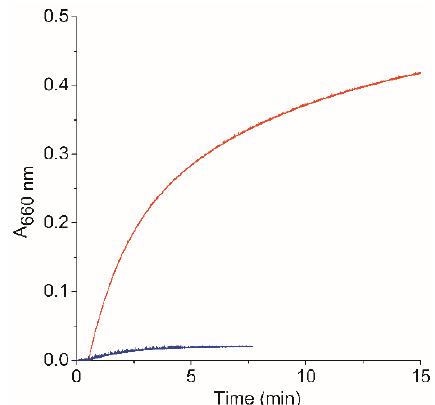
Figure 4. Catalytic activity of MIMO@LA@AuNPs. Time-dependent absorption at 660 nm of ABTS + during ABTS oxidation, as observed in the resuspended pellet (red curve) and the supernatant (blue curve) of the MIMO@LA@AuNPs solution, after centrifugation. Reaction conditions were: 5.0 mM ABTS and 10.0 mM H 2 O 2 in 50.0 mM phosphate buffer pH 6.5, 50% 2,2,2-trifluoroethanol (TFE) ( v / v ).